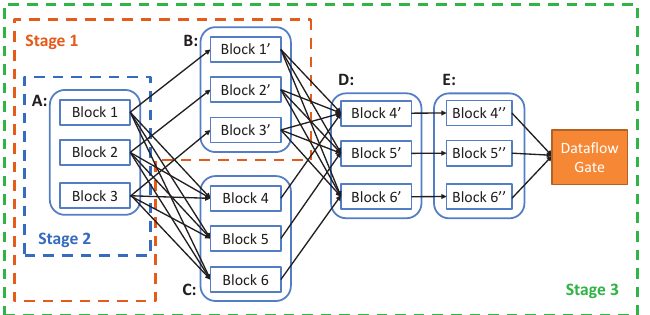
Figure 7. Example of parallel computing on dataflow. In this scenario, parallel computing is divided into three stages (Stages 1, 2, and 3), among which Stage 1 can be computed in the process of data streaming